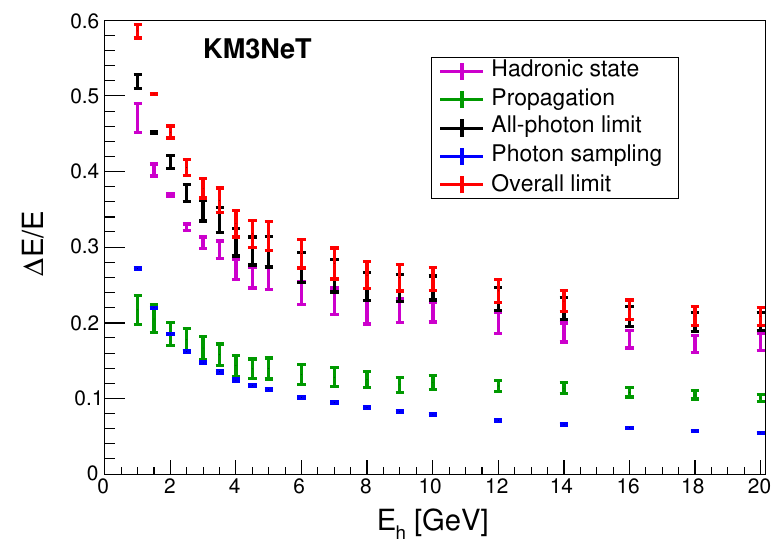
Figure 5 . Relative errors (RMS) in reconstructed energy for hadronic cascades, due to hadronic state (purple), particle propagation (green), their combined e(cid:11)ect in the all-photon limit (black), and the additional variation introduced due to photon sampling (blue) in the overall limit (red). The mean is calculated from the average between the G-GHEISHA (larger) and G-FLUKA (smaller) results, and the error bars cover the range between